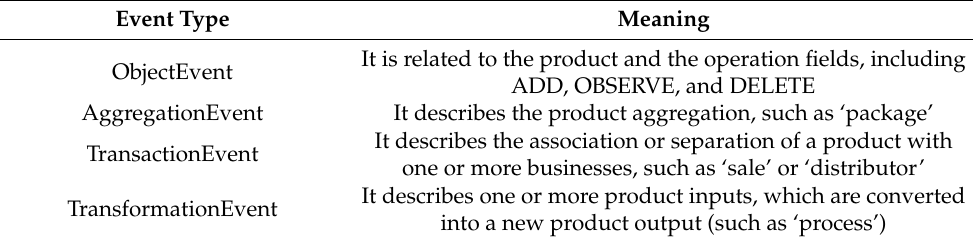
Table 3. EPCIS Event